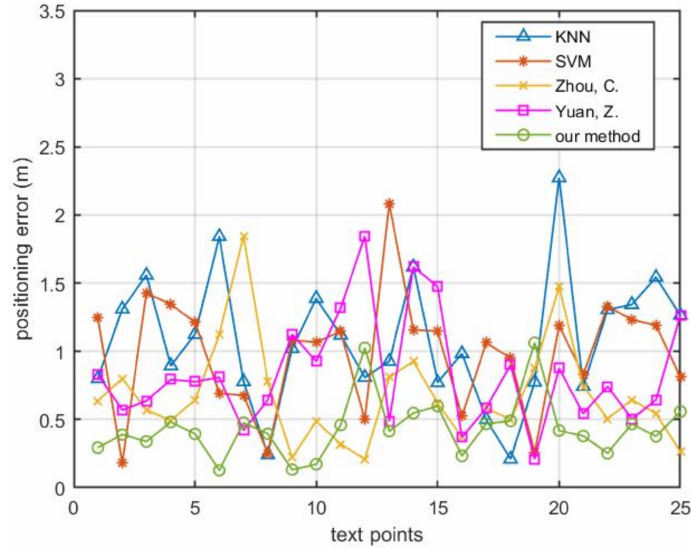
Figure 12. Comparison of positioning errors of different positioning algorithms.